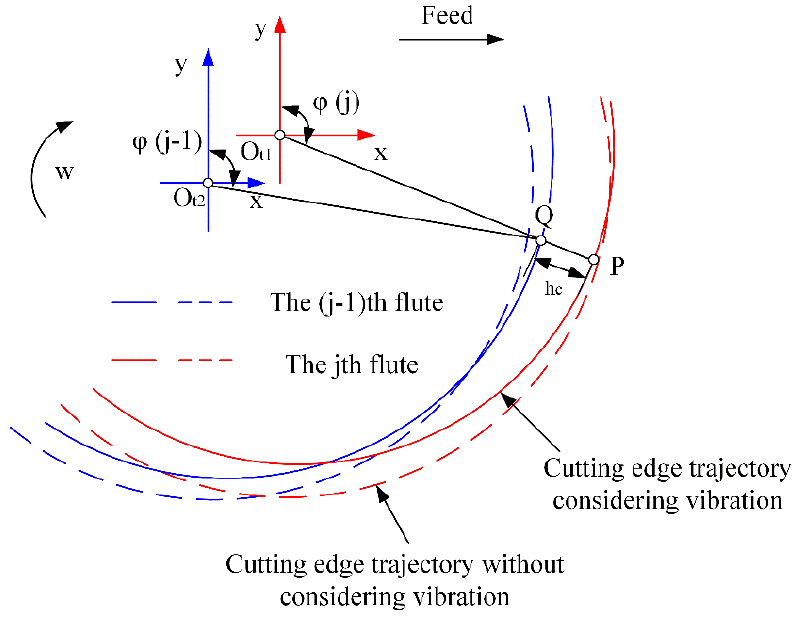
Figure 25. Analysis of the cutting-edge trajectory.